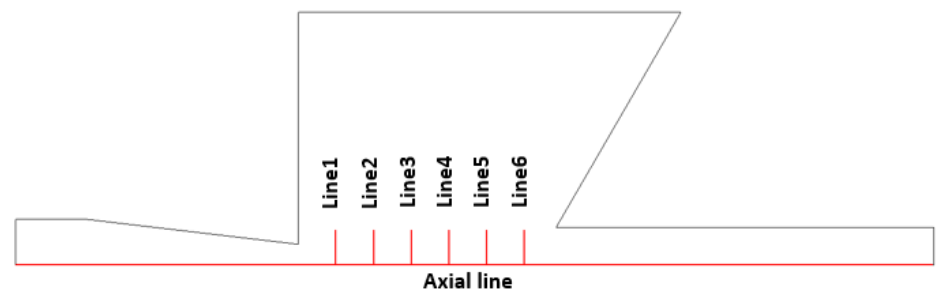
Figure 9. The distribution of monitor lines.